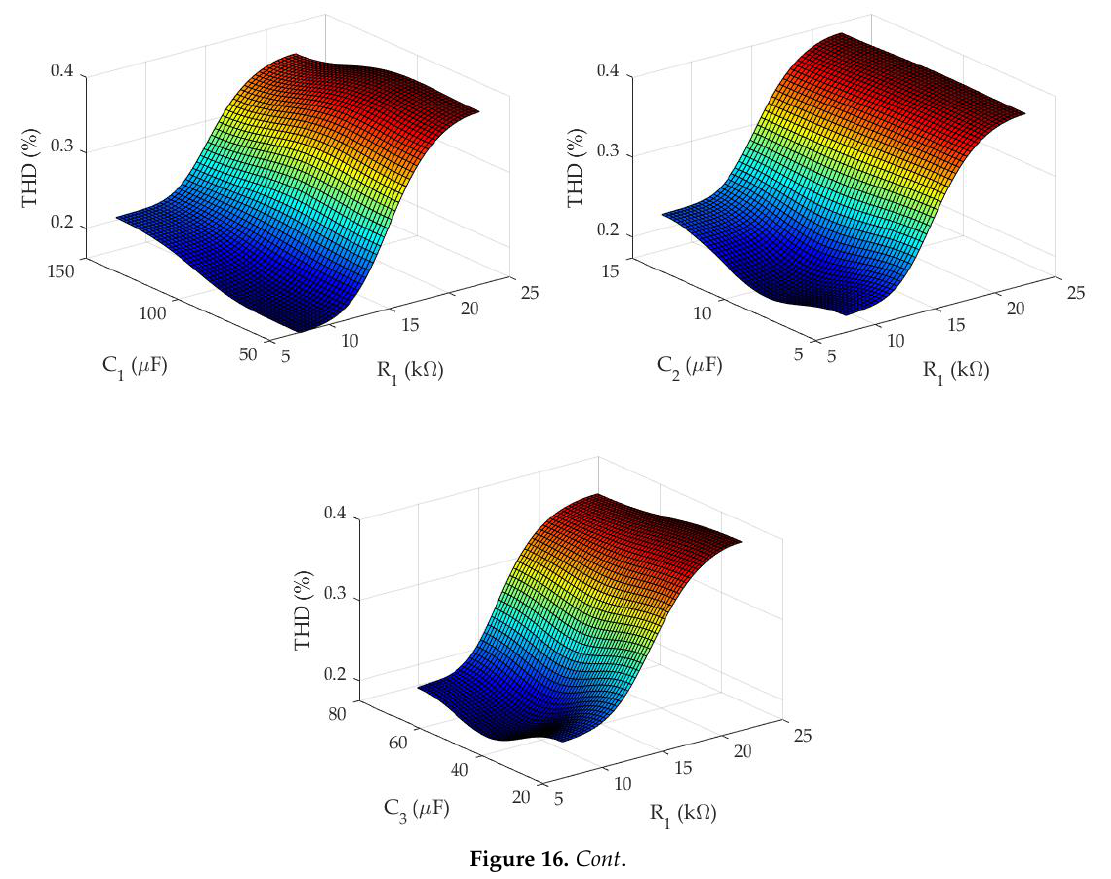
Figure 15. Results of the tuned FIS in the second step for THD: ( a ) training data; ( b ) validation data.